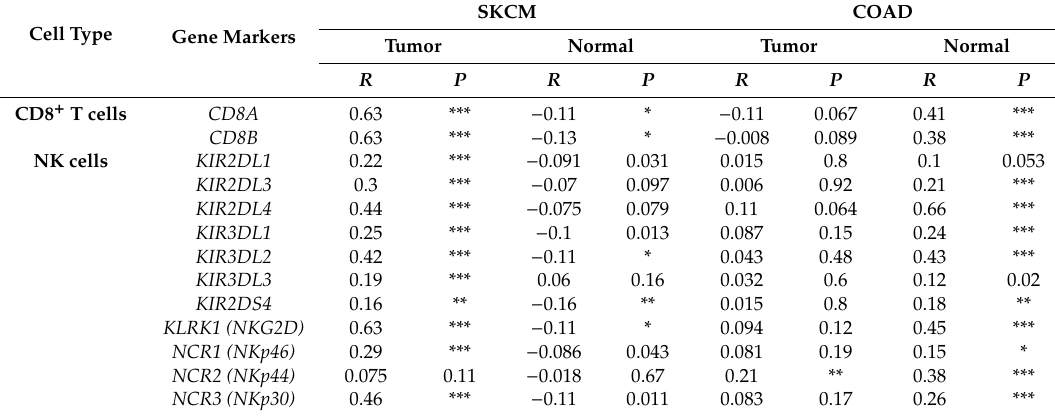
Table 2. Correlation between IL18 and markers of CD8 + T and natural killer (NK) cells in